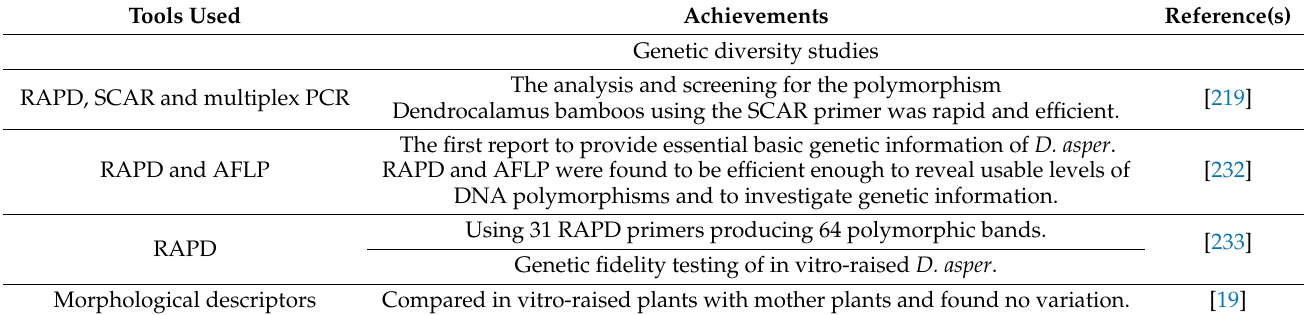
Table 4. The details of genetic diversity studies and output of D. asper using various molecular bamboos. Tools Used Achievements Reference(s) Genetic diversity studies The analysis and screening for the polymorphism RAPD, SCAR and multiplex PCR Dendrocalamus bamboos using the SCAR primer was rapid and